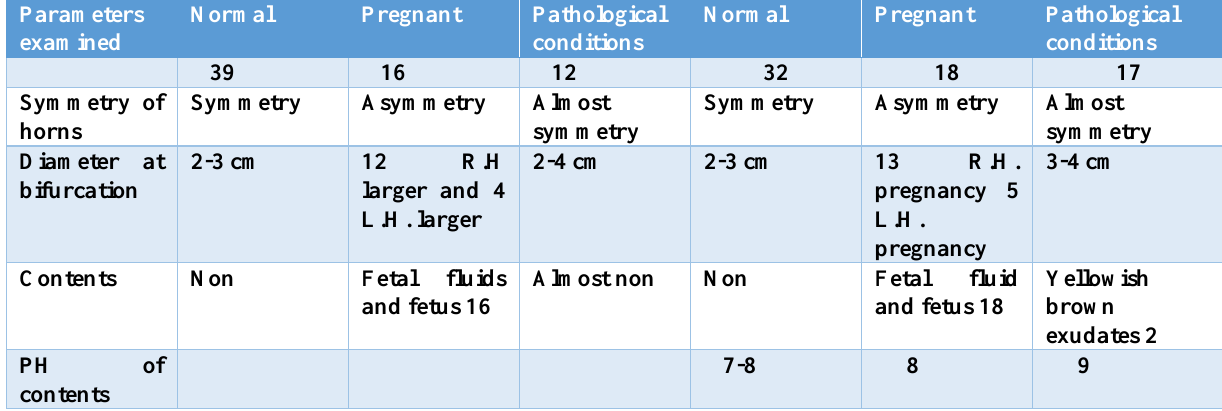
Table, 3: Pre and post slaughter findings in examination of the uterus . Pre-slaughter (Rectal palpation)